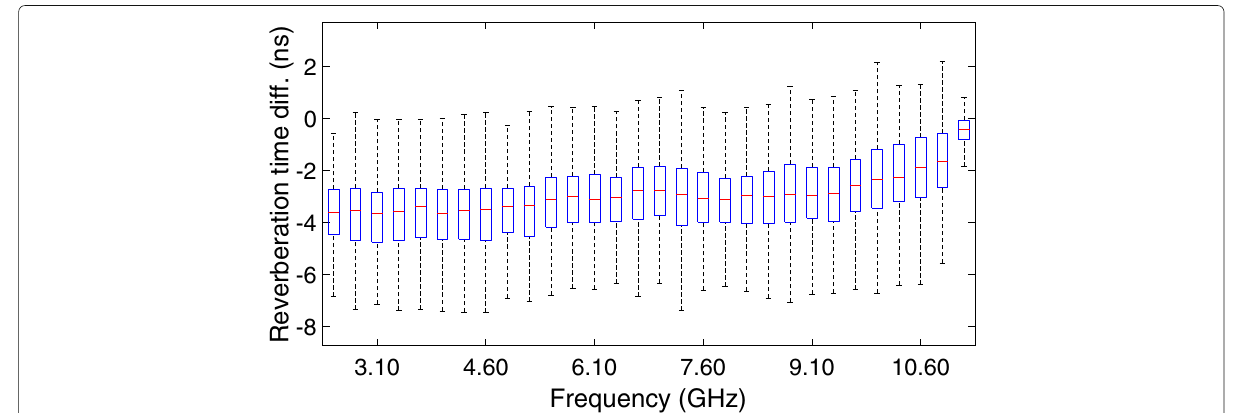
Fig. 8 Box plot of the differences between the input and output reverberation time